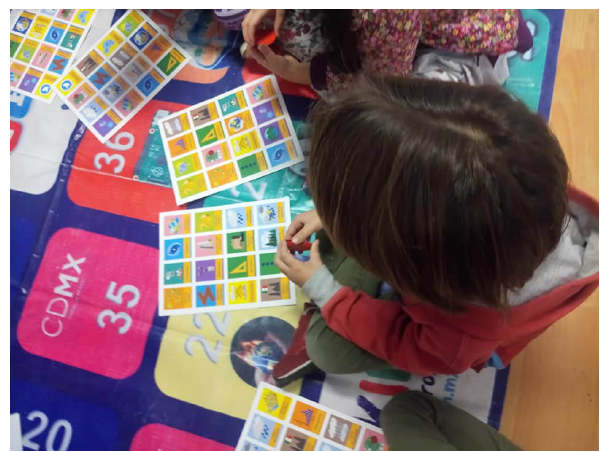
Figure 3. Group of students playing water bingo during one of the